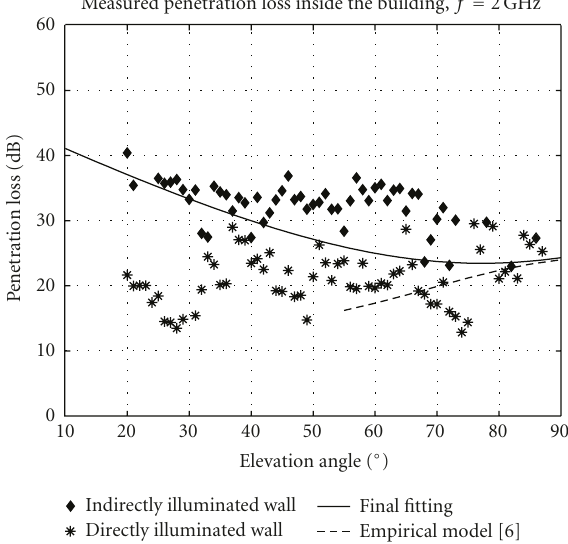
Figure 8: Penetration loss as a function of the elevation angle for di ff erent scenarios, f = 2 . 0 GHz.